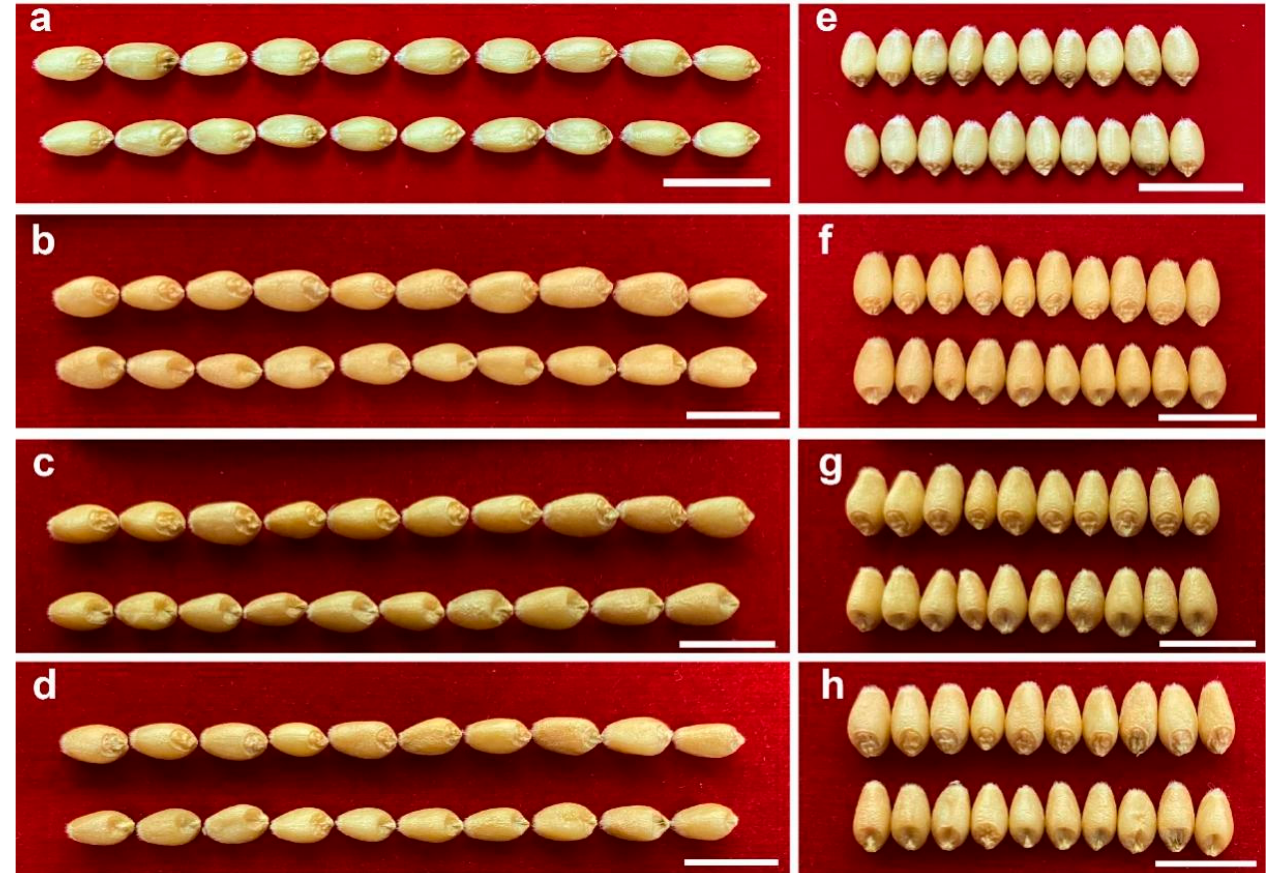
Figure 4. Wheat grain features of the embryoless and normal grains of the mtl mutants. ( a , e ) Comparison on grain length and width between wild-type (upper line) and mtl-A (lower line); ( b – d ) Comparison on grain length between embryoless grain (lower line) and normal grains (upper line) from mtl-AD , mtl-BD , and mtl-ABD ; ( f – h ) Comparison on grain width between embryoless grains (lower line) and normal grains (upper line) from mtl-AD , mtl-BD , and mtl-ABD . Scale bar = 1 cm.